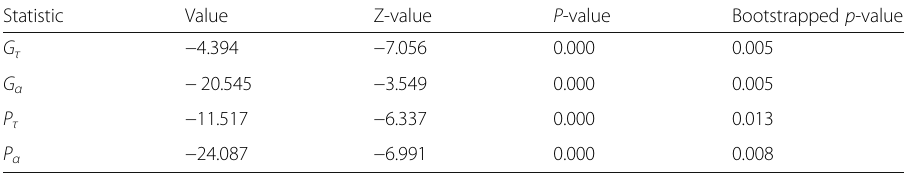
Table 5 Panel Bootstrap Cointegration Test (Excluding Indonesia And Brunei) Statistic